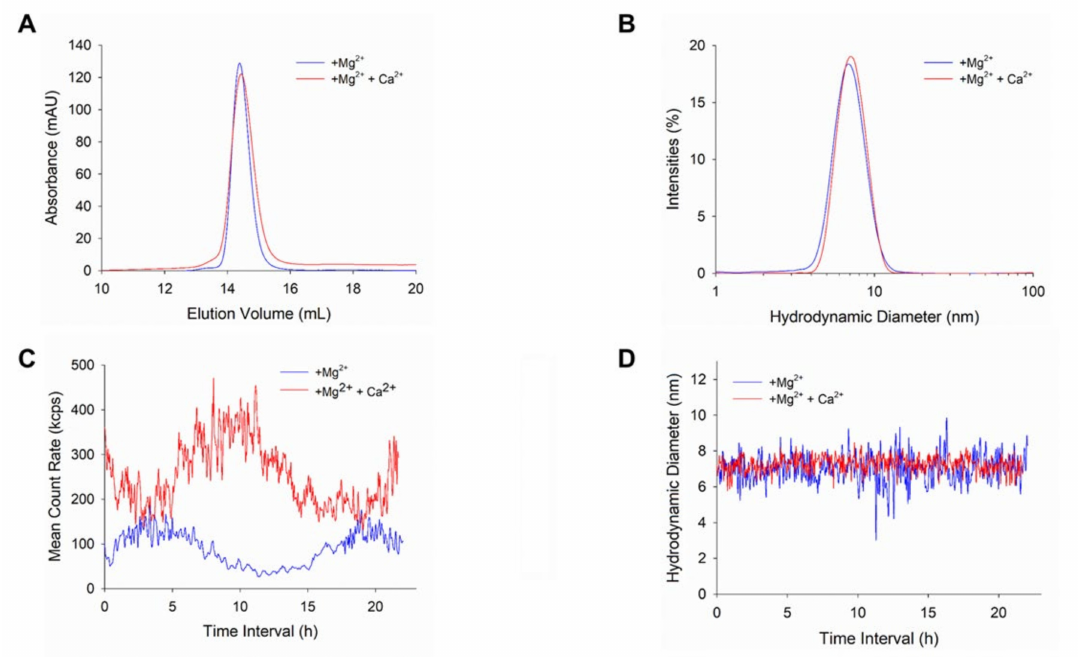
Figure 8. Analysis of N104H-GCAP1 quaternary structure. ( A ) Analytical gel filtration profile of ~45 µ M N104H-GCAP1. Chromatographic runs were carried out in either 500 µ M EGTA + 1 mM Mg 2+ (blue) or 1 mM Mg 2+ + 1 mM Ca 2+ (red). ( B ) Hydrodynamic diameter of ~45 µ M N104H-GCAP1 monitored by DLS in the presence of 500 µ M EGTA + 1 mM Mg 2+ (blue) or 1 mM Mg 2+ + 1 mM Ca 2+ (red). Solid lines represent the mean curve of 30 measurements. Time evolution over 22 h of the mean count rate ( C ) and ( D ) peak 1 mean intensity of ~45 µ M N104H-GCAP1 in the presence of 500 µ M EGTA + 1 mM Mg 2+ (blue) or 1 mM Mg 2+ + 1 mM Ca 2+